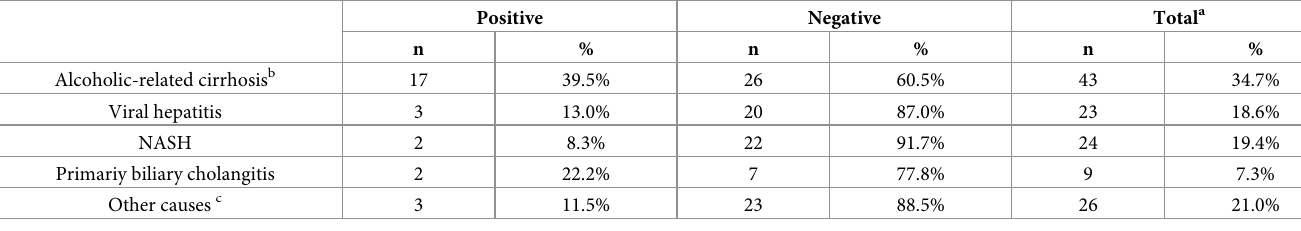
Primariy biliary